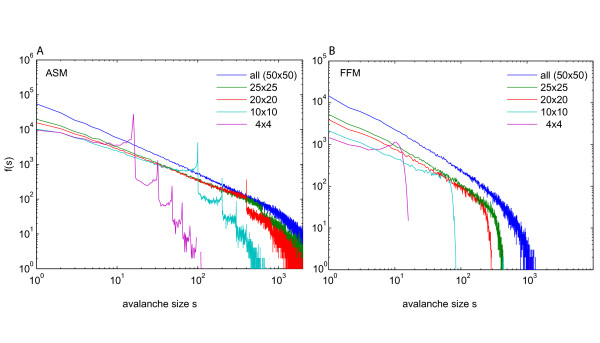
Approximation of a power law distribution with increasing coverage of the system when subsampling. Avalanche size distributions f(s) from models of grid size 50×50, sampled on centred, compact subareas of size 4×4 (purple), 10×10 (light blue), 20×20 (red), 25×25 (green) and fully sampled (blue). (A) ASM. (B) FFM. Note, how the characteristic subsampling effects vanish for the ASM (peaks) and the FFM (peak, steep drop off) with increasing coverage of the system.